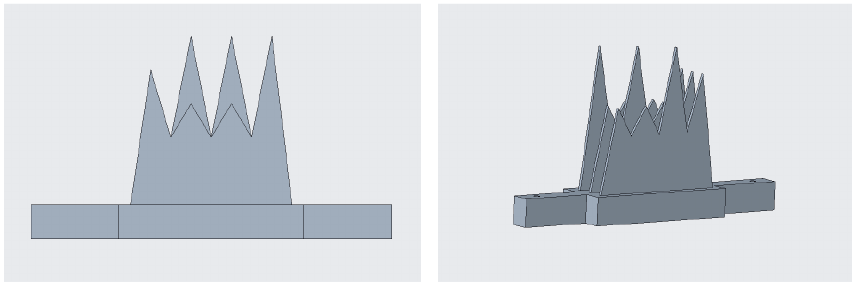
Figure 4. The ad hoc phantom designed for the calibration: frontal view on the ( left ), and perspective view on the ( right ).